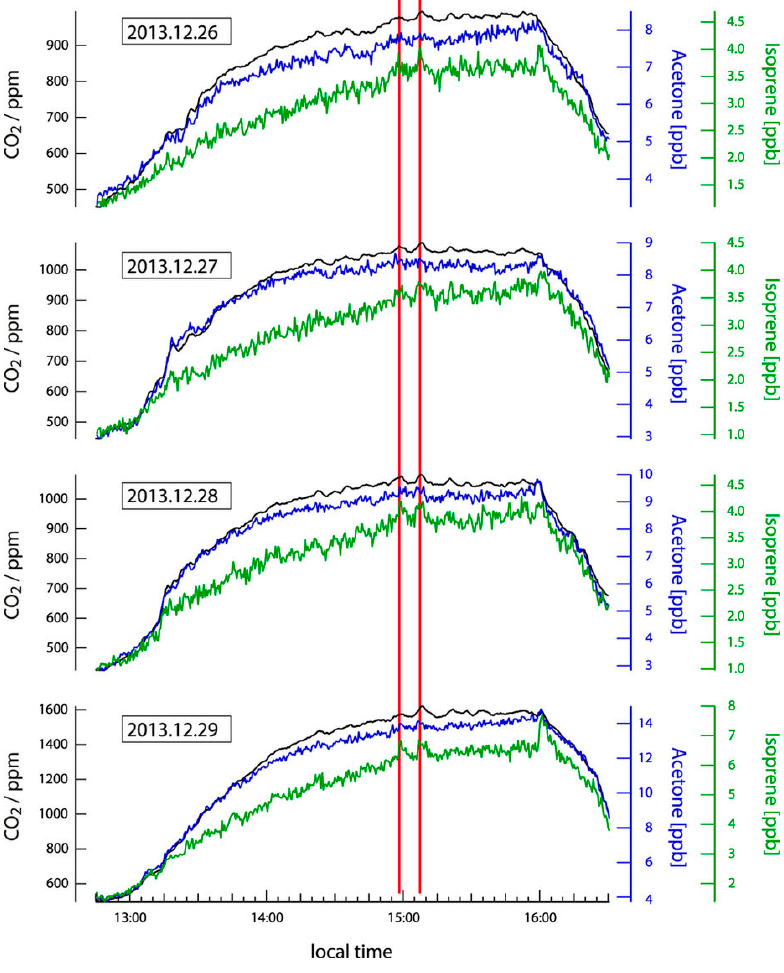
Figure 19. Measurements of CO 2 , isoprene and acetone taken during four separate screenings of “Hunger Games 2”. Used with permission from